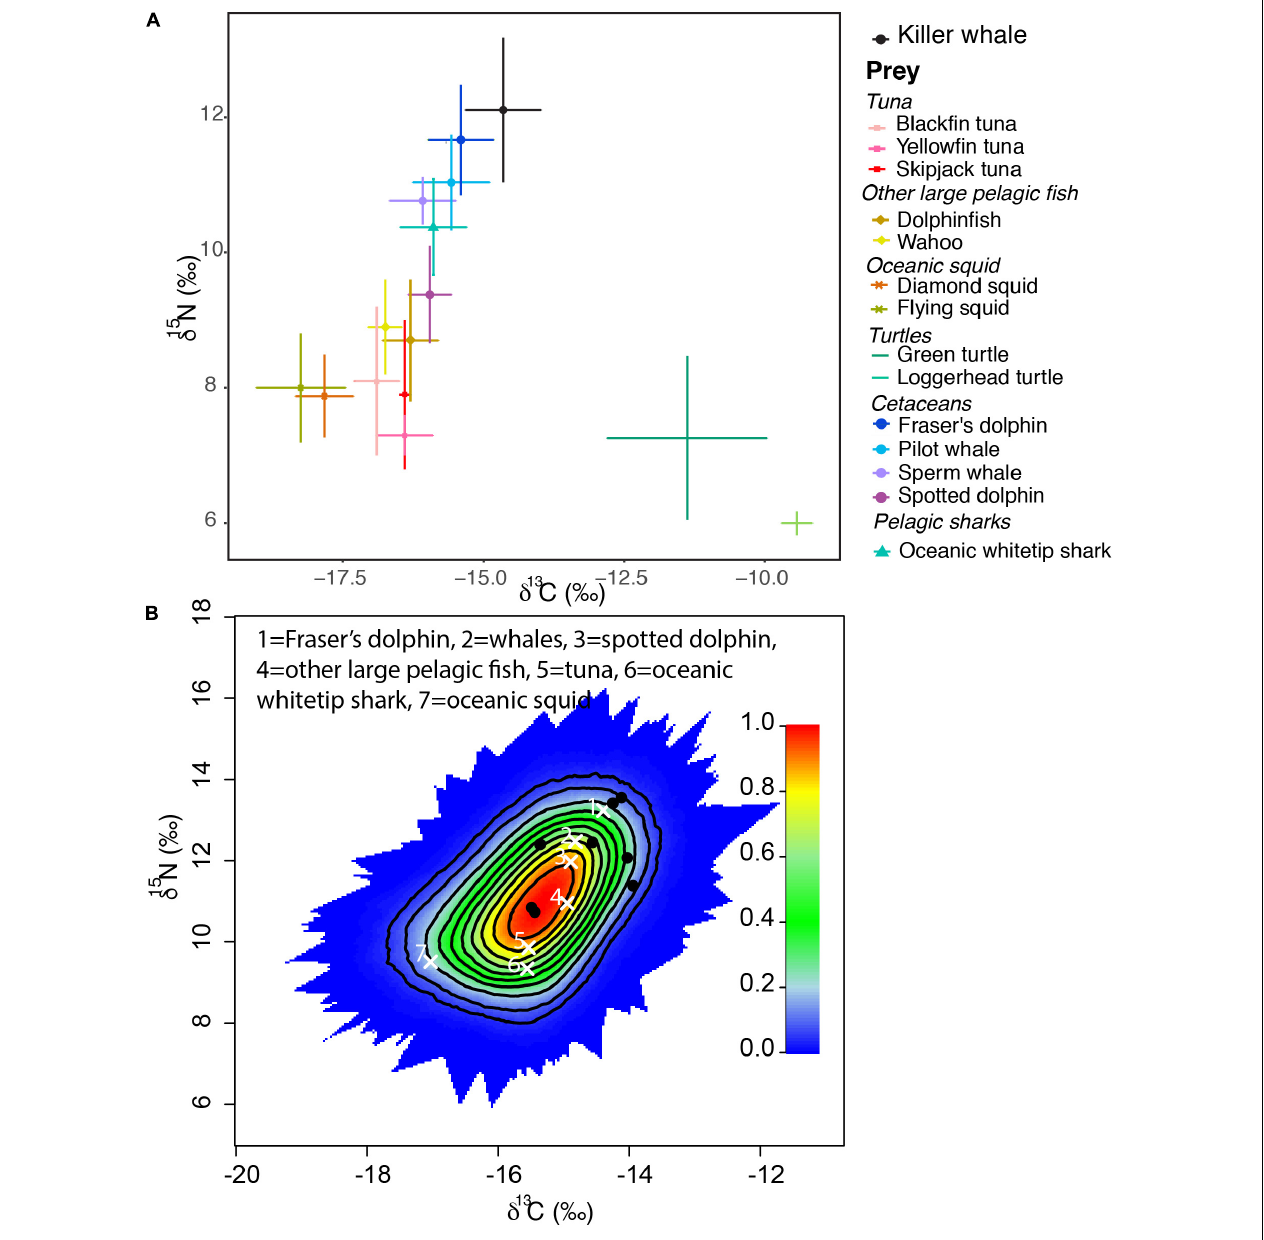
FIGURE 1 | (A) Mean carbon ( δ 13 C) and nitrogen ( δ 15 N) isotope values ( ± SD) of killer whales and their potential prey in the Caribbean Sea and; (B) a simulated mixing polygon of the biplot in panel (A) , including the average source signatures (white crosses) and position of the killer whale consumers (black dots). Probability contours start at the 5% level and every 10% level